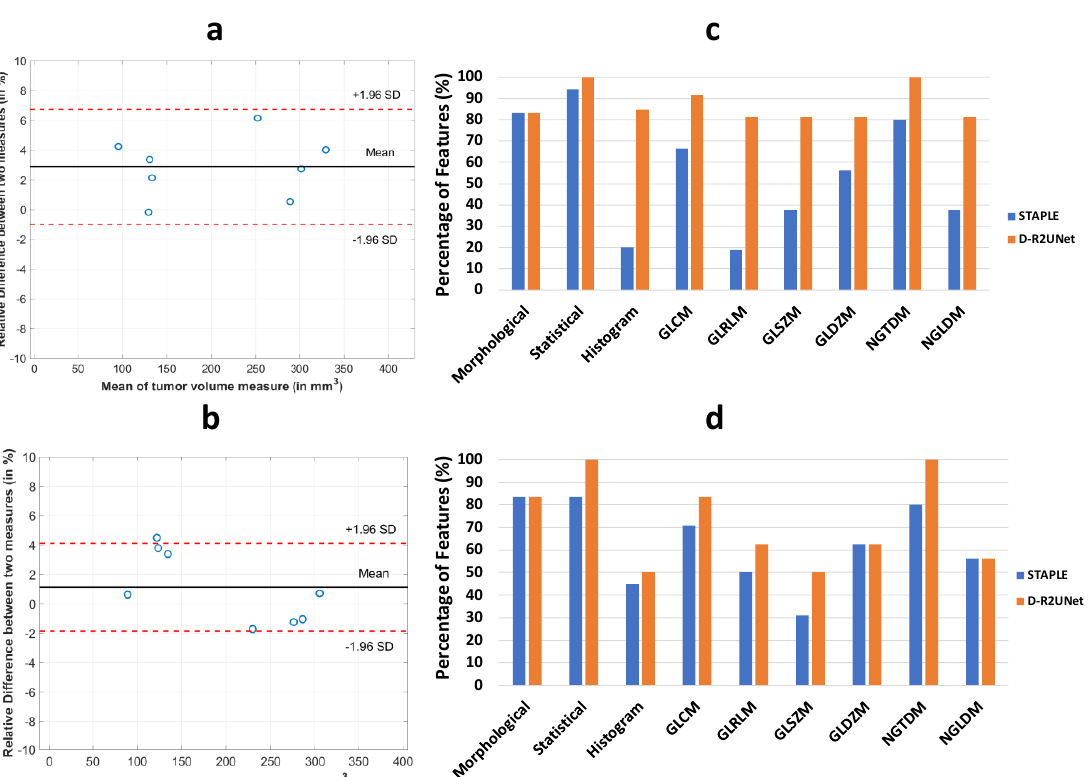
Figure 6. Reproducibility analysis of the D-R2UNet relative to the STAPLE: ( a ) Bland–Altman plot for test–retest for the expert delineation after application of STAPLE. The experts delineated the same set of tumor volume within a one-week gap under identical conditions. ( b ) Bland–Altman plot for test–retest for the D-R2UNet algorithm. The algorithm was re-trained in randomly shuffled data and tested on the same test data to evaluate the robustness of the algorithm. ( c ) Percentage of T1w radiomic features having CCC ≥ 0.9 extracted from STAPLE generated maps and automated maps ( d ) Percentage of T2w radiomic features having CCC ≥ 0.9 extracted from STAPLE -generated maps and D-R2UNet maps.